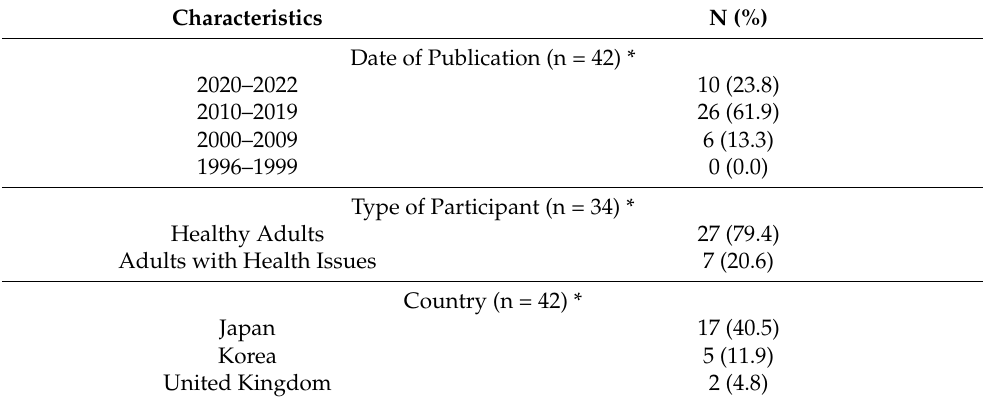
Figure 1. Flow Diagram and Screening Process of Included Empirical Studies. Table 2. Descriptive Characteristics of HRV Studies in Outdoor